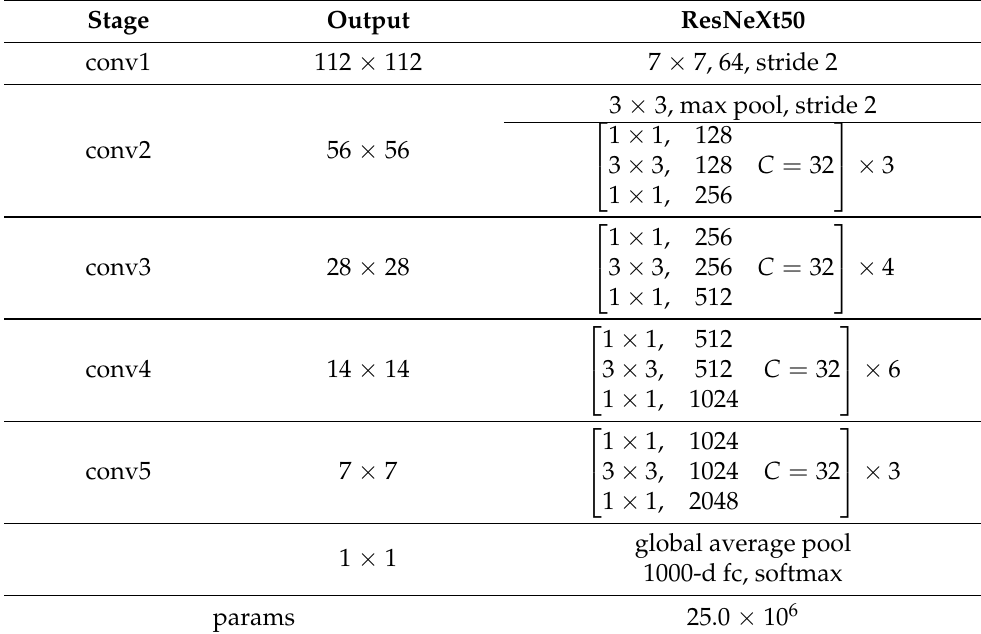
Table 1. The structure of